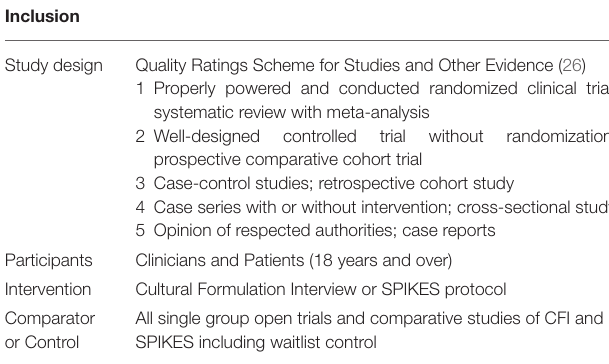
TABLE 1 | Inclusion table.